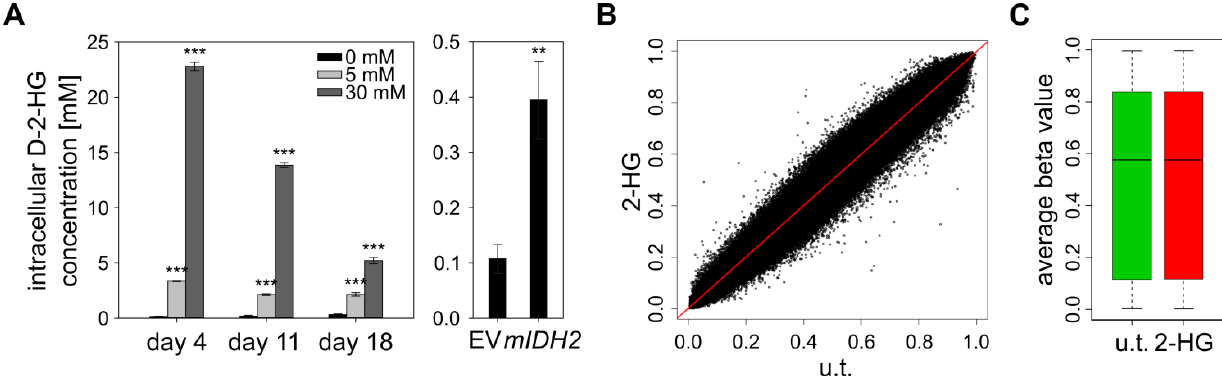
FIGURE 5: D-2-HG does not induce genomic hypermethylation in cultured cells. (A) Measurement of intracellular D-2-HG concentrations using an enzymatic conversion assay [50]. HL-60 cells were cultured in medium containing 5 or 30 mM synthetic D-2-HG and quantifications of intracellular concentrations were performed at the indicated time points. The right panel shows intracellular concentrations in HL-60 cells transduced with empty vector (EV) or mIDH2 . Statistical significance was calculated using the two-sided Student's t -test (*** P <0.001 and ** P <0.01). (B) Comparison of methylomes from D-2-HG treated (2-HG; 30 mM for 21 days) and untreated (u.t.) HL-60 cells by scatterplot. No significantly changed probes (adj. P <0.05) were found analyzing two biological replicates of each condition by EPIC methylation array. (C) Boxplot of average beta values of all probes in untreated and D-2-HG treated (30 mM for 21 days) HL-60 cells ( P